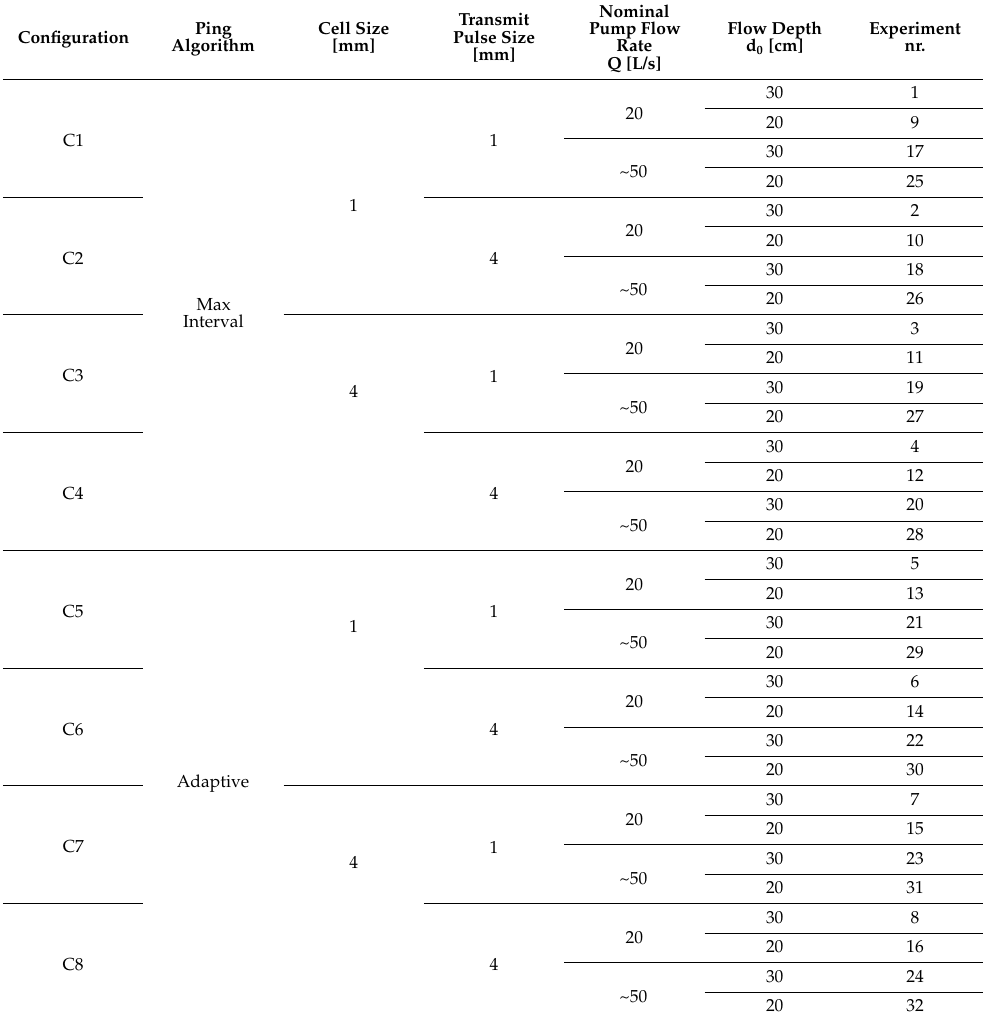
Table 2. Configuration of ADVPs’ operation parameters and corresponding flow scenarios used for the